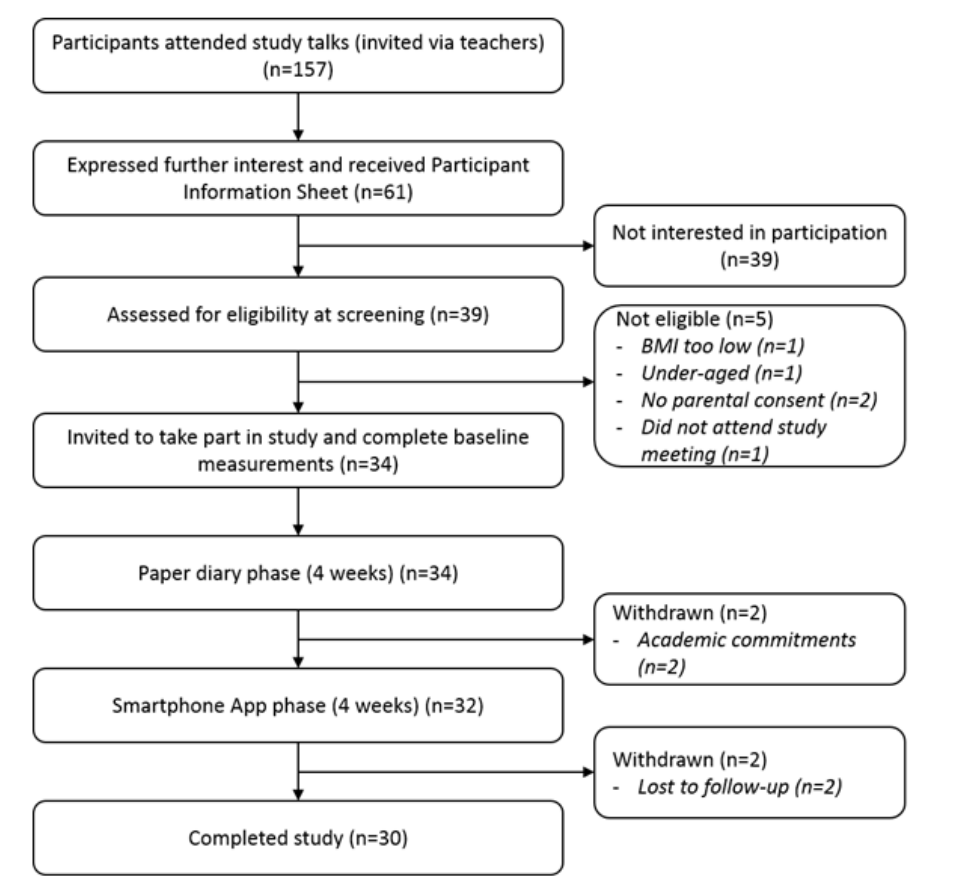
Figure 1. Diagram showing the flow of participants through the